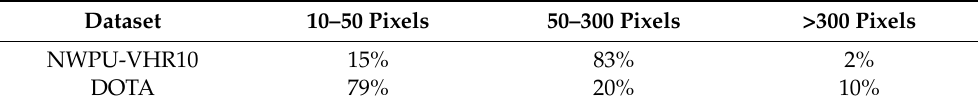
Table 1. The distributions of the instance size for the NWPU-VHR10 and DOTA datasets.